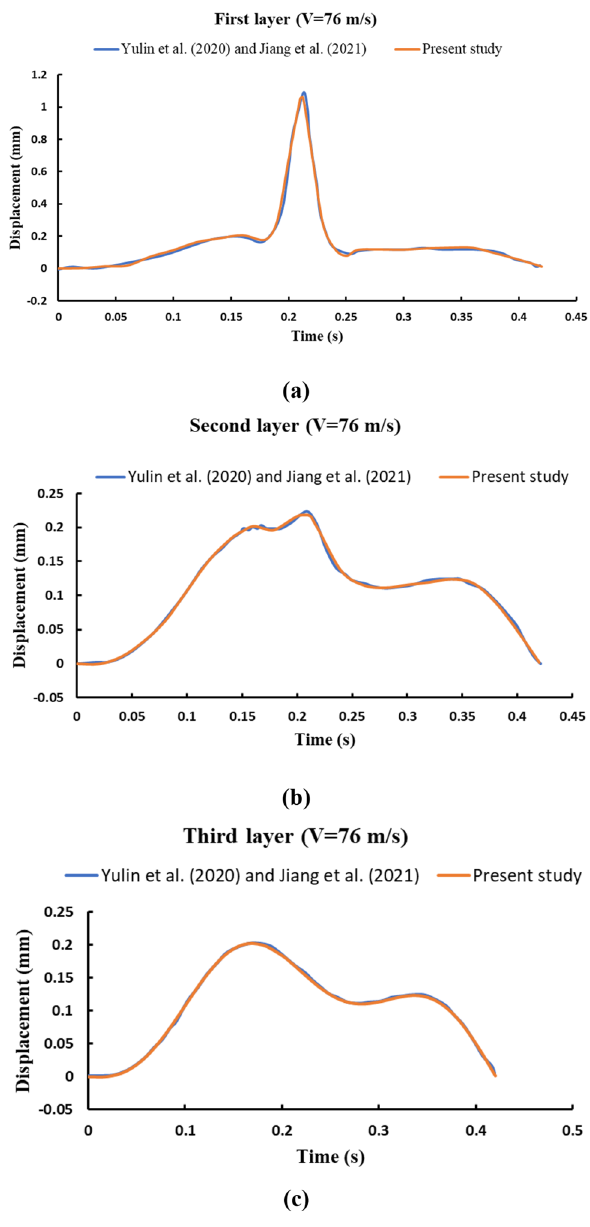
Figure 3. Comparison of dynamic response of triple beam system ( a ) first layer ( b ) second layer and ( c ) third layer.